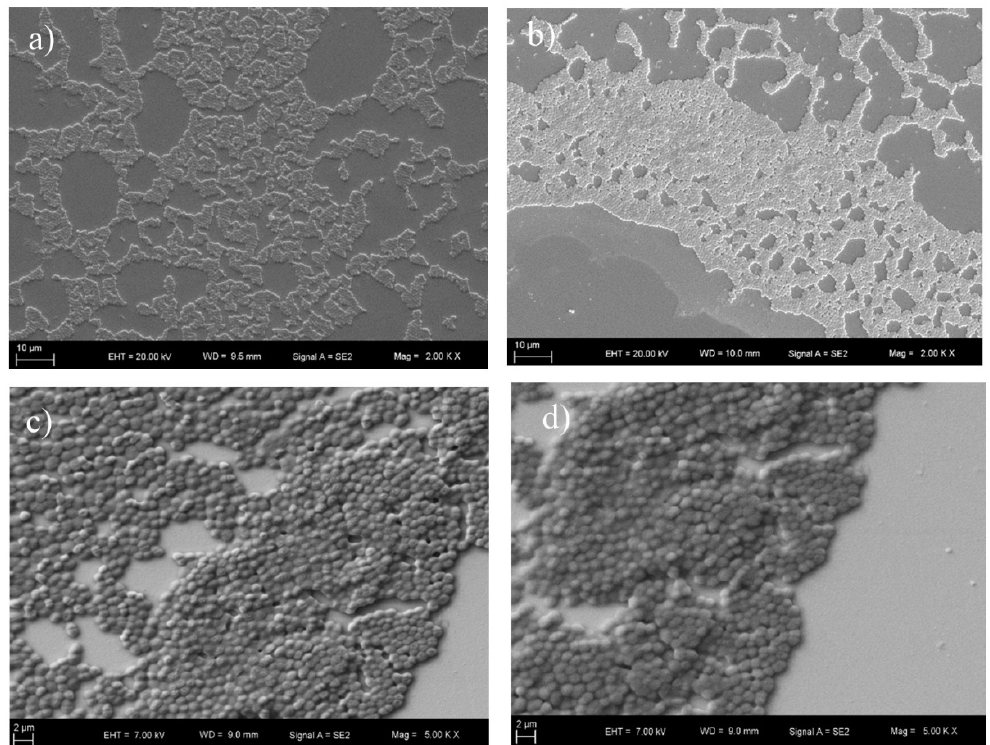
Figure 8. SEM micrographs of the bacteria with antibiotic treatment. ( a ) Methicillin-resistant S. aureus at 2 KX magnification; ( b ) methicillin-susceptible S. aureus at 2 KX magnification; ( c ) vancomycin-resistant enterococci at 5 KX magnification; ( d ) vancomycin-susceptible enterococci at 5 KX